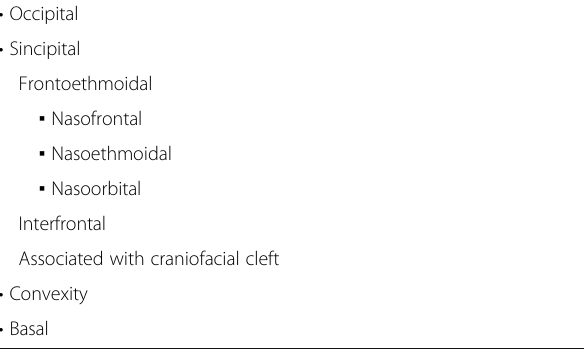
Table 1 Summarizing the classification of encephaloceles